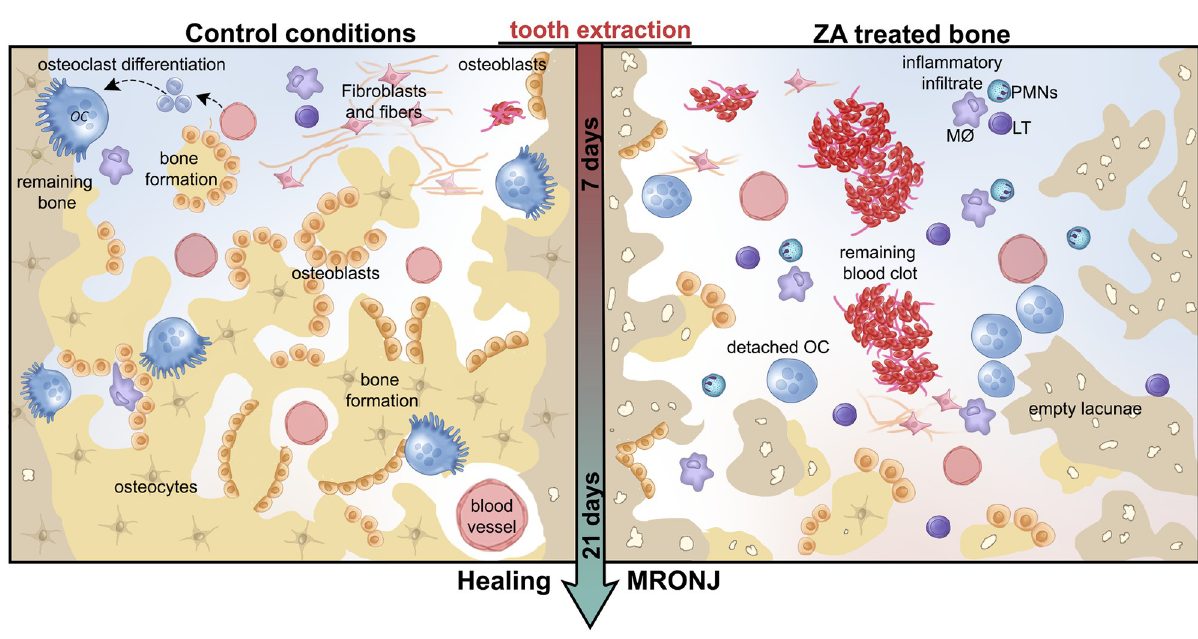
Fig 8. Graphical representation of microscopic events during initial and late time points post tooth extraction in control conditions compared to MRONJ model in senescent 129 Sv WT female mice. In summary, senescent 129 Sv female mice treated with cumulative dosages of Zoledronic acid present a disrupted healing process post tooth extraction compared to Control conditions. While bone formation and remodeling occurs along 21 days in control conditions, in the MRONJ phenotype, a delayed blood clot and debris removal, increased inflammatory infiltration, increased occurrence of empty lacunae and bone sequestrum, detached osteoclasts are seen until the later time points of 21 days.